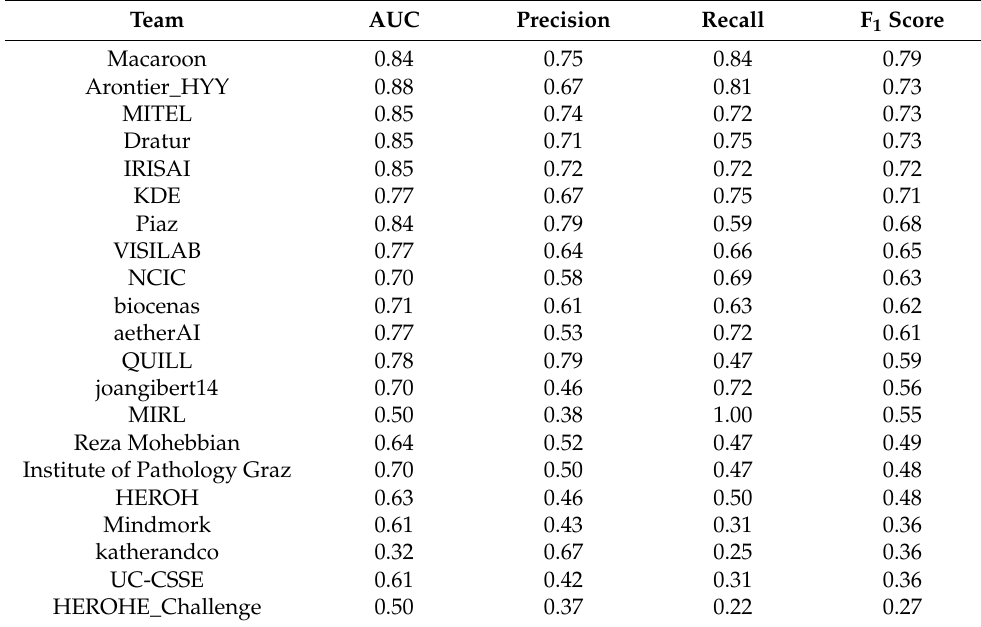
Table 5. Classification of the HEROHE Challenge in the subset of equivocal cases by IHC (score of 2+).